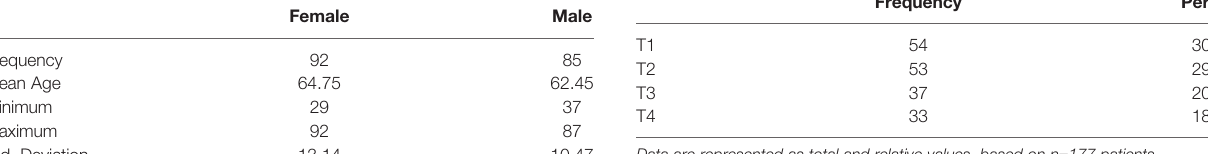
Data are represented as total and relative values, based on n=177